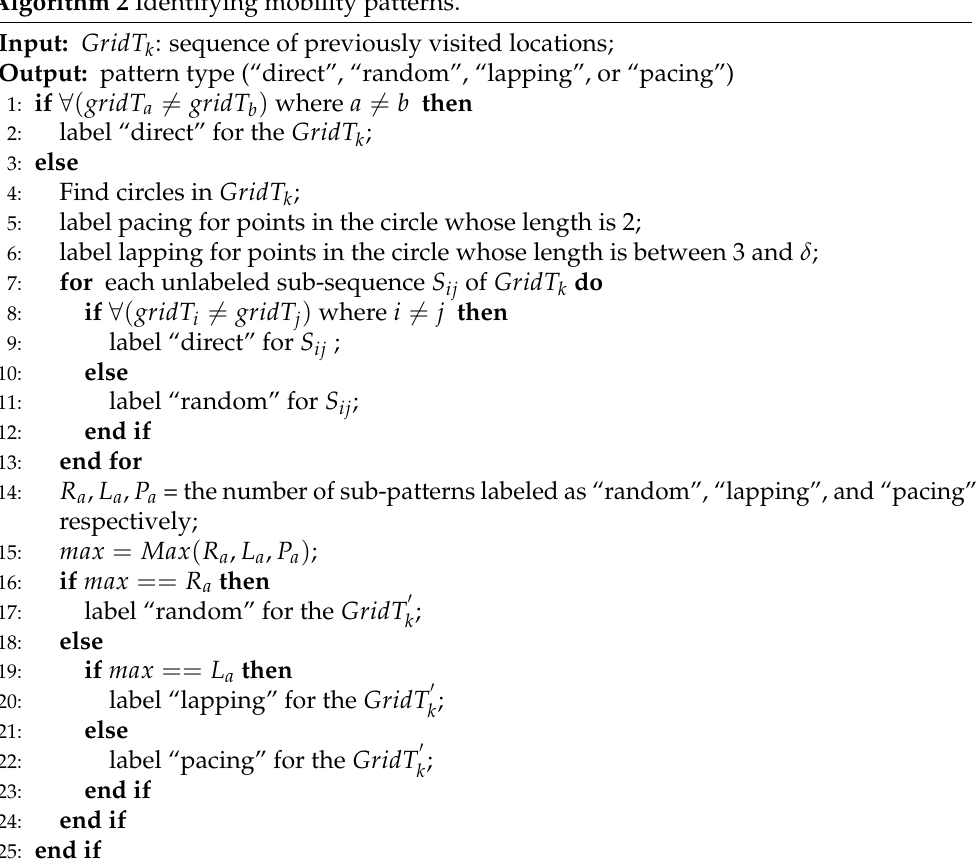
Algorithm 2 Identifying mobility